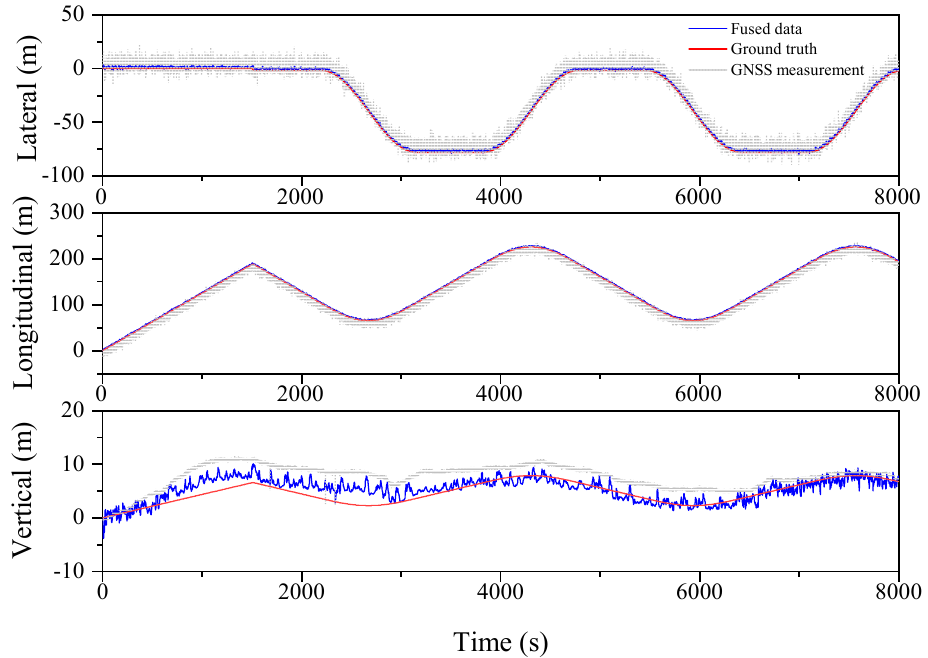
Figure 4. Lateral, Longitudinal and Vertical positions of ESKF (Oval).